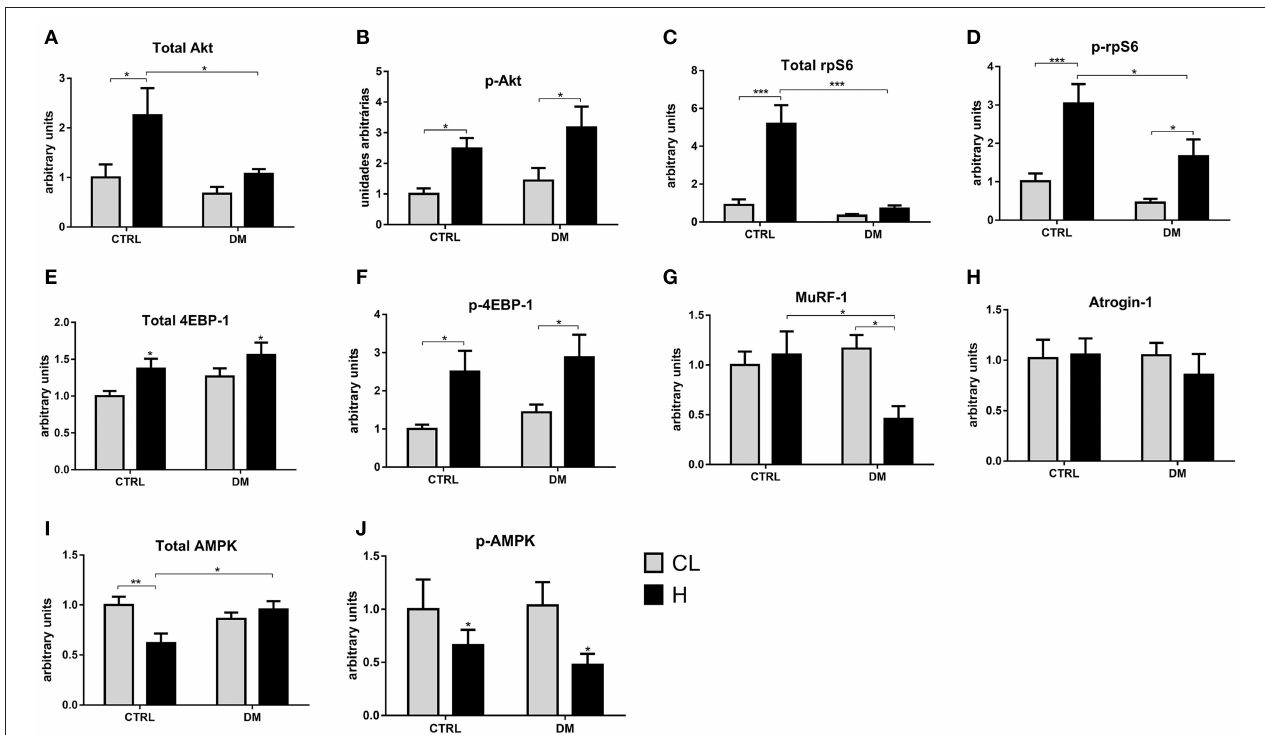
FIGURE 4 | (A–D, F–I) Contents of signaling proteins associated with protein synthesis and degradation in the EDL muscle after 7 days of overload. Quantitative analysis of western blotting of total and phosphorylated Akt, rpS6, AMPK, MuRF-1 and atrogin-1 of the EDL muscle. Results are expressed as mean ± SEM of at least six animals. * p < 0.05, ** p < 0.01, *** p < 0.001 using two-way ANOVA followed by Bonferroni post-test. In (E,J) , * p < 0.05 CTRL-CL/DM-CL vs. CTRL-H/DM-H using two-way ANOVA only. CTRL, Control group; DM, Diabetic group; CL, Contralateral; H, Hypertrophy. Western blotting gels and ponceau staining are presented in Supplementary